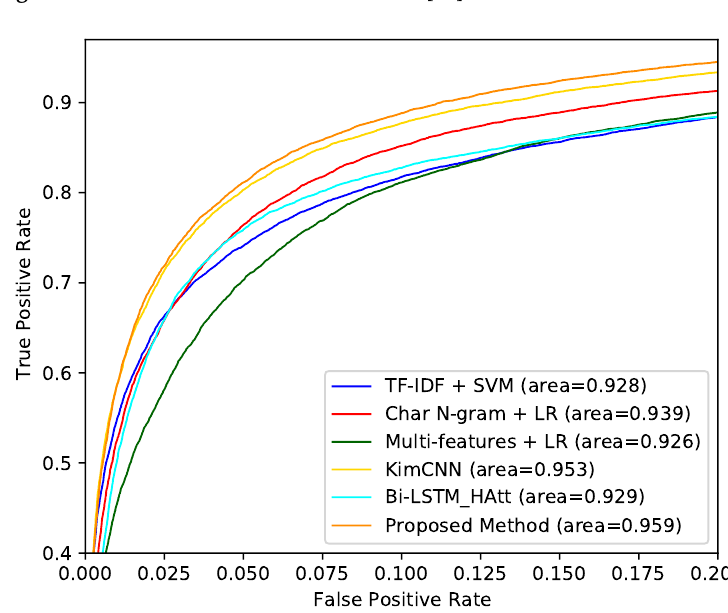
Figure 5. The ROC curve of dataset Wikiapedia